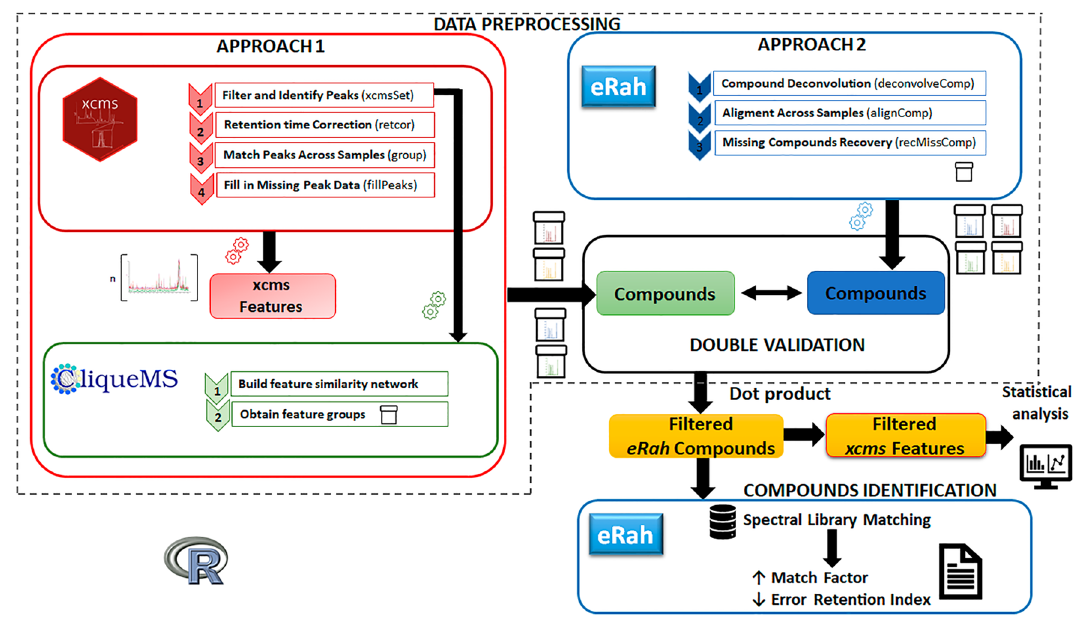
Figure 2. Workflow for data preprocessing after exhaled breath analysis using TD-GC/q-MS.